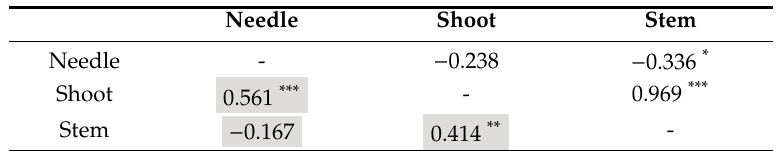
Table 3. Correlation matrix between primary (needle, shoot) and secondary growth (stem) for larch (white background) and spruce (grey Table 4. Pearson correlation coefficients between tree growth (primary and secondary) and environmental factors of larch and spruce.